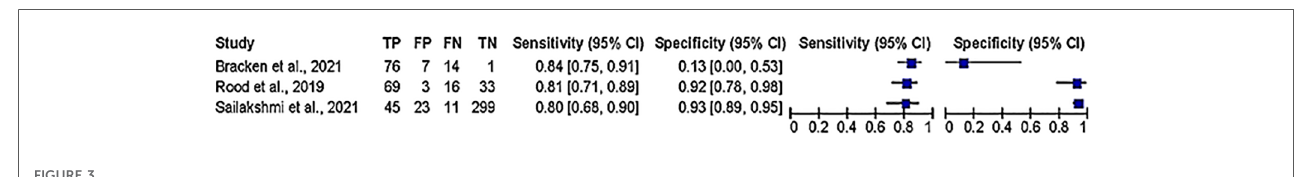
FIGURE 3 Evaluating sensitivity and speci fi city of CRDP test in detection of hypertensive disorder of